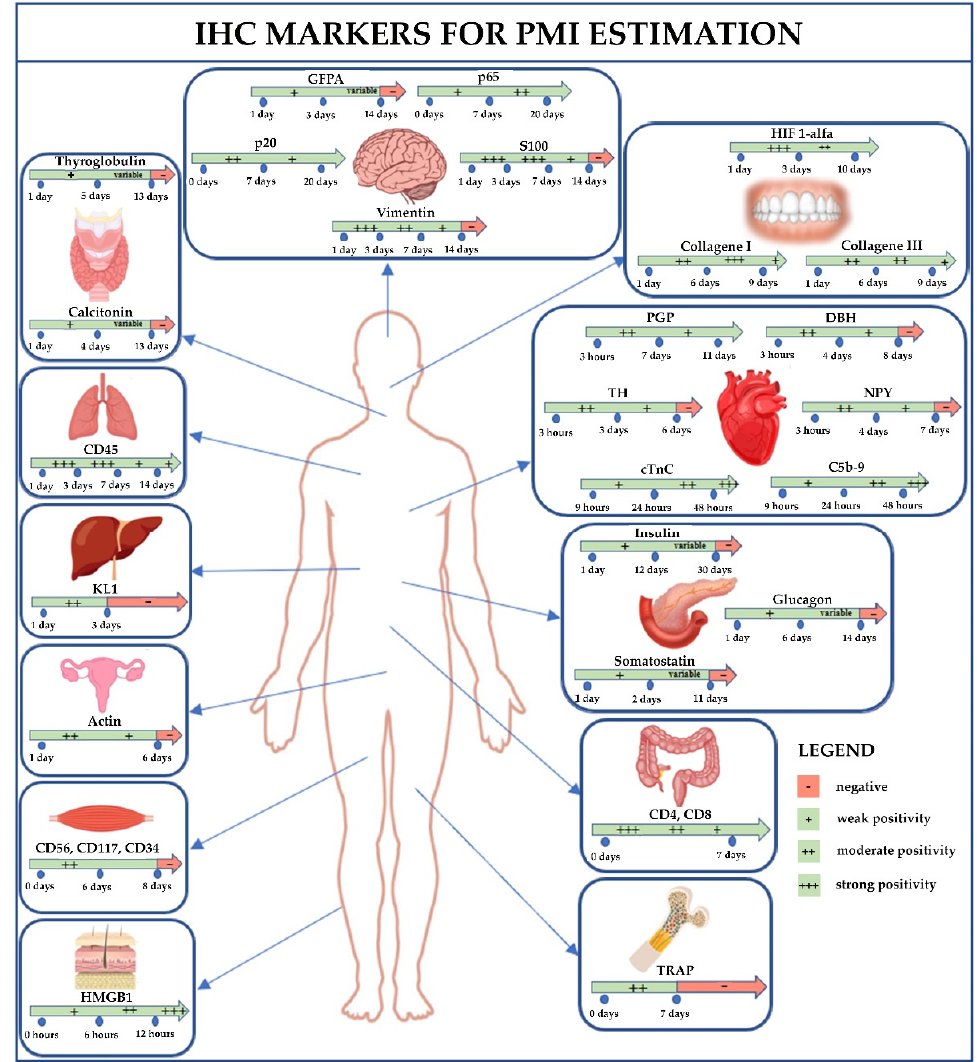
Figure 2. This picture summarizes the results of this review: the IHC results depend on tissue and type of immunostaining, which varies depending on the PMI. For each tissue is reported the related marker; moreover, in each box, there is an arrow: the green color indicates the interval time with positivity result, while the red color indicates the time when the marker became negative. List of abbreviations: IHC, immunohistochemical; PMI, post-mortem interval; PGP, Protein gene product; DBH, Dopamine β -hydroxylase; TH, Tyrosine hydroxylase; NPY, Neuropeptide Y; GFAP, glial fibrillary acidic protein; TRAP, Tartrate-resistant acid phosphatase; HIF 1-alfa, Hypoxia-inducible factor 1-alpha; cTnC, cardiac Troponin C; HMGB1, High-mobility group box-1; KL1, Cytokeratin